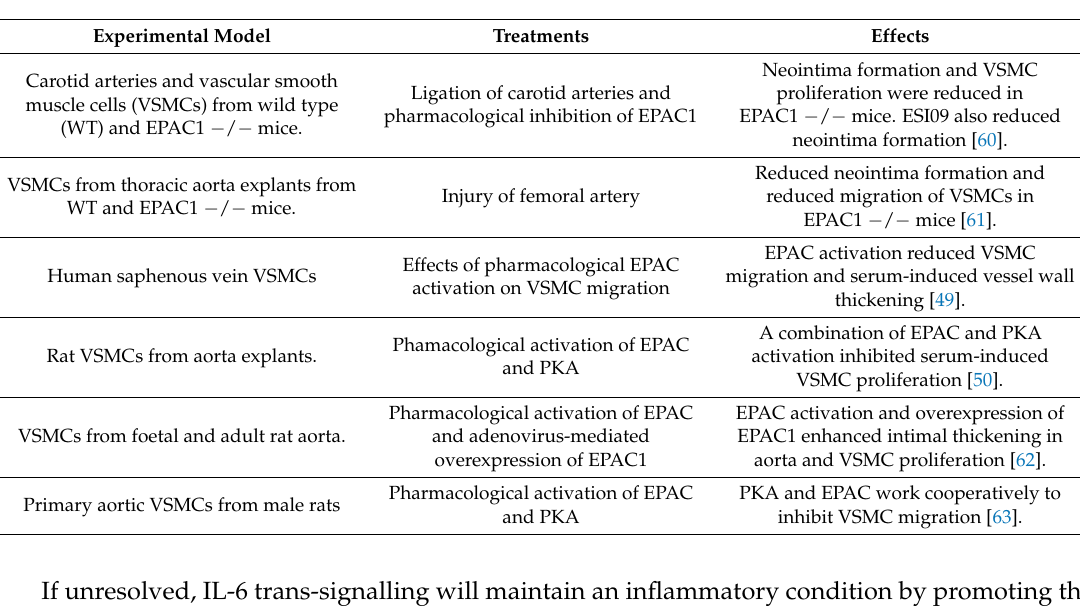
Table 1. Effects of EPAC1 on experimental neointimal hyperplasia.